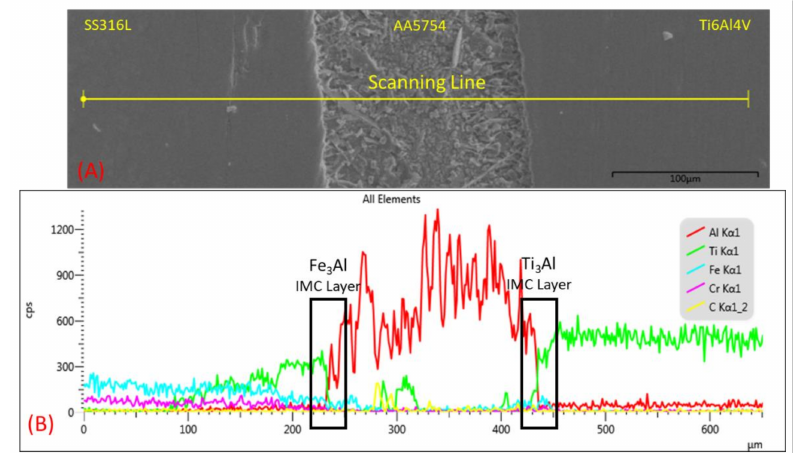
Figure 15. Fe, Al, and Ti distributions across the SS–Al–Ti joint interface from sample 3: ( A ) EDX scanning line; ( B ) chemical composition along the scanning line